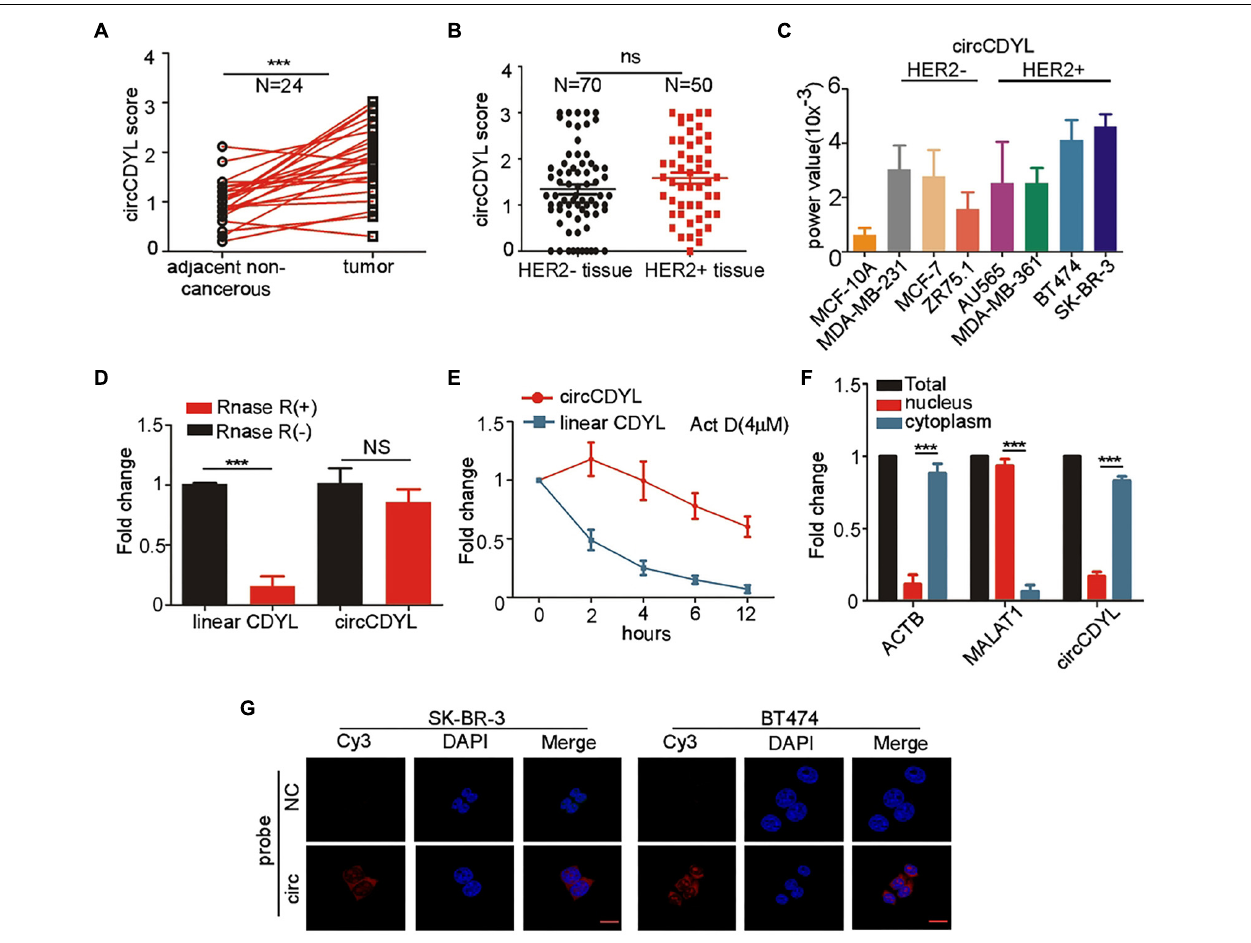
FIGURE 1 | CircCDYL is high-expressed in HER2 + BC. (A) Comparison of circCDYL expression between HER2 + BC tissues and paired adjacent non-cancerous tissues by ISH ( n = 24). (B) Expression of circCDYL in HER2 − BC tissues ( n = 70) and HER2 + BC tissues ( n = 50), as detected by ISH . (C) Expression of circCDYL in normal mammary epithelial cells (MCF-10A), HER2 − BC cell lines (MCF-7, MDA-MB-231, and ZR75-1) and HER2 + BC cell lines (AU565, MDA-MB-361, SK-BR-3, and BT474), as detected by qRT-PCR. (D) Linear CDYL and circCDYL before or after RNase R digestion was detected by qRT-PCR. (E) qRT-PCR detection of circCDYL and linear CDYL in SK-BR-3 cells treated with Actinomycin D (4 µ M) at various times. (F) qPCR analysis of circCDYL in the cytoplasm and nuclear separated from SK-BR-3 cells. (G) Cellular location of circCDYL in SK-BR-3 and BT474 cells, as detected by FISH. All experiments above were done for at least three times. *** P < 0.005. Error bars indicate Standard Error of Mean